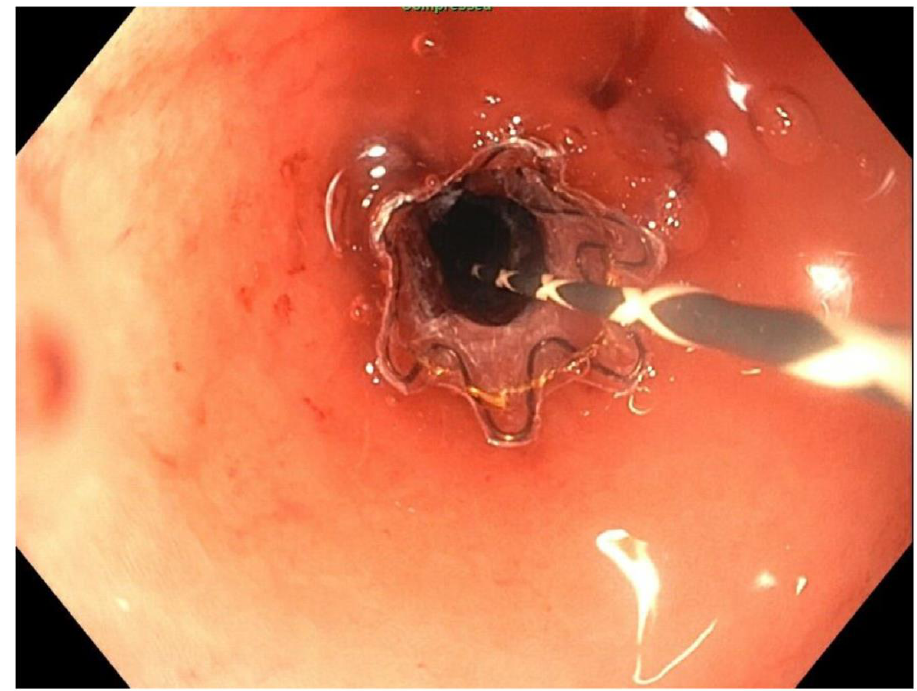
Figure 18. Covered stent insertion (endoscopic view).